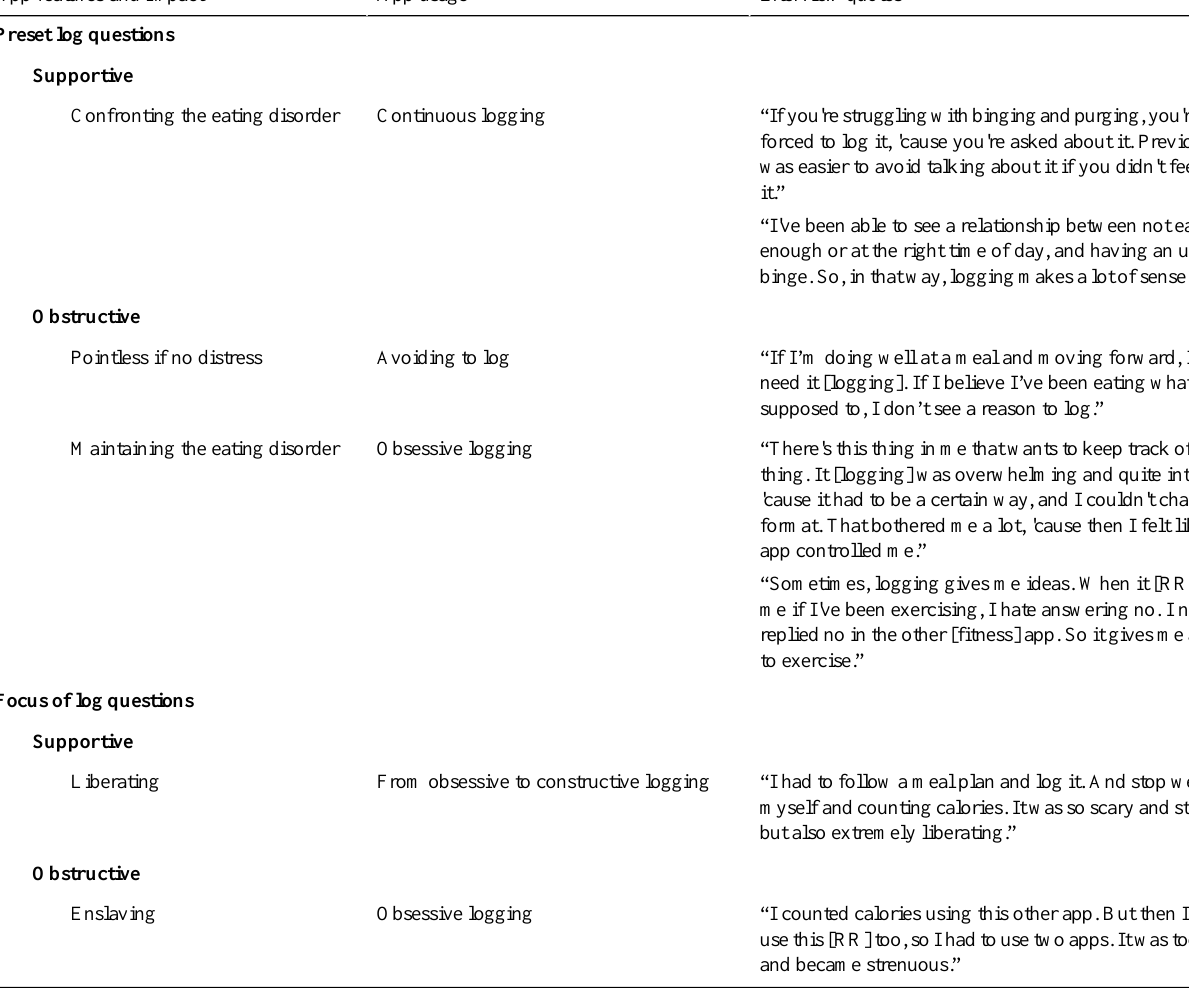
Table 4. Patients’ experiences with the Recovery Record (RR) meal log features. The table summarizes the individual patient-app interaction, that is, the specific features related to meal logs, the impact of these on patients, and patients’specific app usage supported by interview